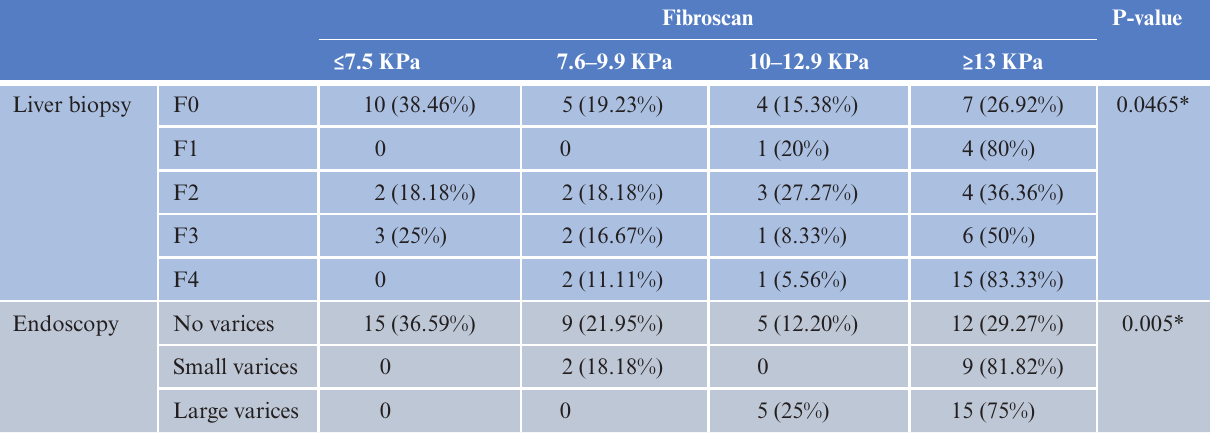
Table 1: Correlation between liver biopsy, endoscopy, and Fibroscan